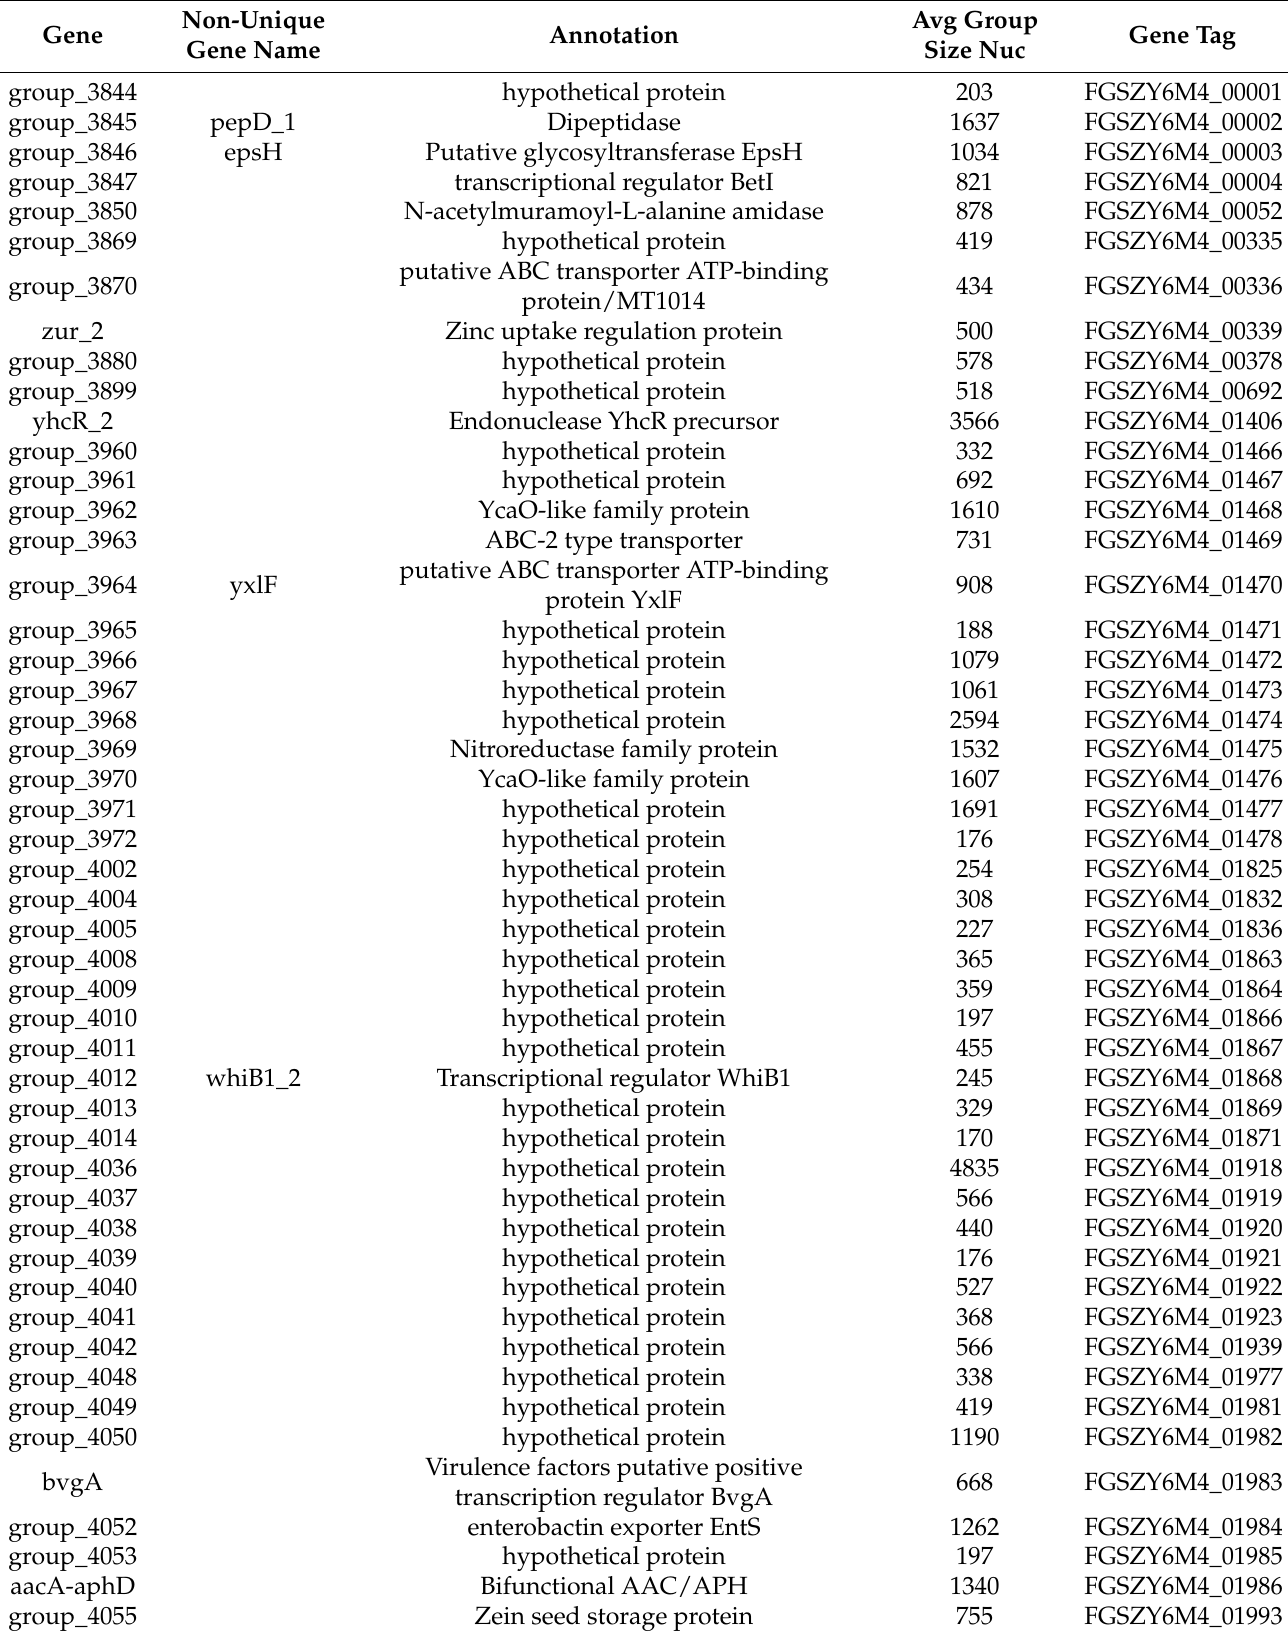
Table 6. Strain-specific genes identified by Roary for B. longum